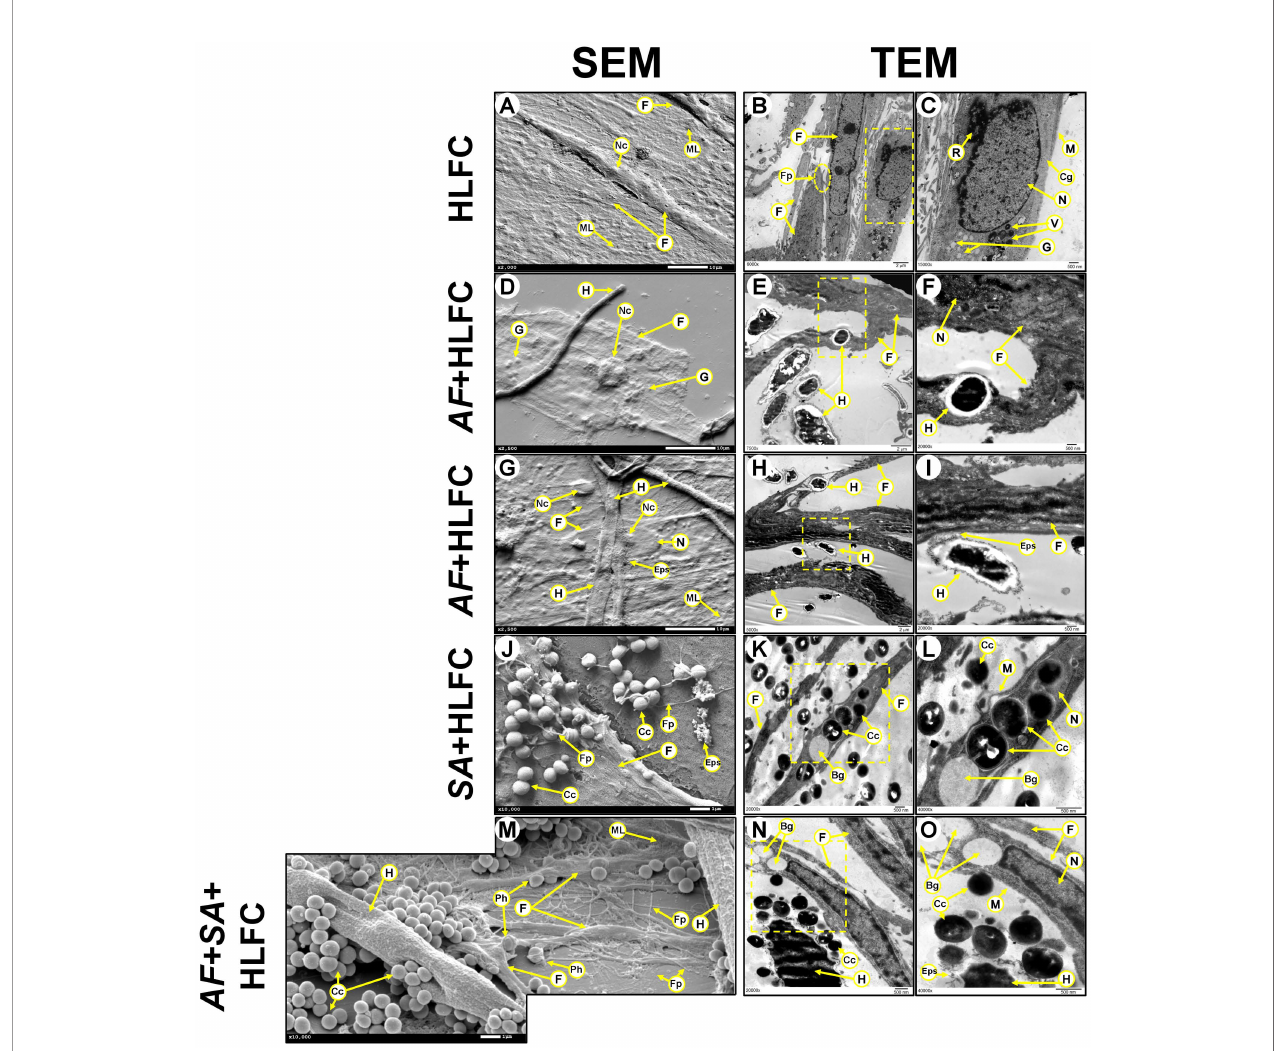
FIGURE 3 | Bio fi lm formation on HLFCs at 24 h. HLFC: A monolayer by SEM [ (A) : 2,000×] and its ultrastructure by TEM ( B : 6,000×; (C) : 15,000×x). AF+HLFC: Fungal penetration.( D : 2,500×). Hyphae through the fi broblast ( E : 7,500×; F : 20,000×). Fungal adhesion: Secretion of ECM over the HLFC ( G : 2,500×; H : 2,500×; (I) : 20,000×). SA+HLFC: The HLFCs form fi lopodia next to cocci ( J : 10,000×). TEM showed cocci divided inside the cells. Note the formation of bacterial interstitial ( K : 20,000×; (L) : 40,000×). AF+SA+HLFC: SEM showed cocci affect the hyphae. HLFC forming fi lopodia. HLFC crescent form and fi lopodia next to cocci. Fungus appears destroyed ( M : 10,000×). TEM showed the antibiosis effect over AF. Intracellular damage in the HLFC with the presence of vacuoles ( N : 20,000×; O : 40,000×). HLFCs, human limbo-corneal fi broblast cells; AF, Aspergillus fumigatus ; SA, Staphylococcus aureus ; H, hypha; F, fi broblast; ML, monolayer; Fp, fi lopodia; asterisk (*), extracellular matrix; R, ribosomes; M, cytoplasmic membrane; Cg, collagen fi bers; N, nucleus; Nc, nucleolus; V, transfer vesicles; G, secretion granules; Eps, exopolymeric substance; Cc, cocci; Bg, interstitial; Ph,